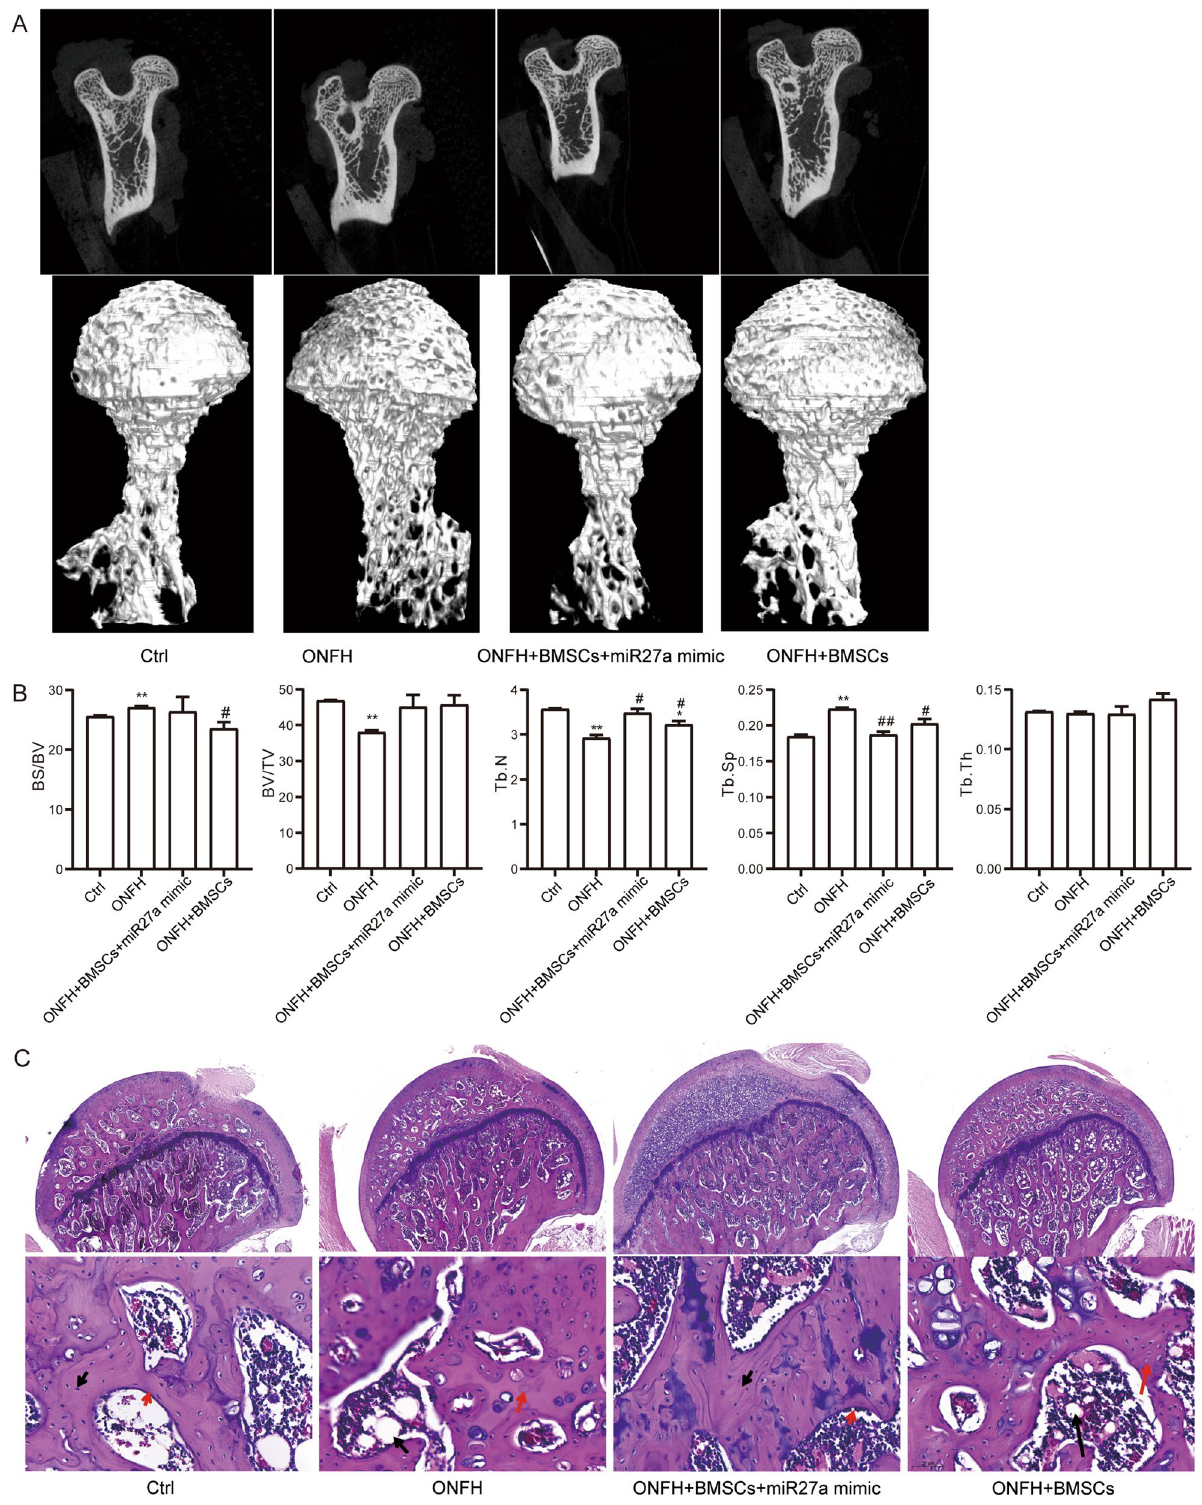
Figure 4. miR-27a protect bone tissue in steroid-induced ONFH rats. ( A ) Micro-CT scanning images of femoral head of rat models. ( B ) The BS/BV, BV/TV, Tb.N, Tb.Th, and Tb.Sp values of rat femoral heads in different groups. ** P < 0.01 vs controls, ## P < 0.01 vs steroid-induced ONFH. ( C ) Hematoxylin–eosin staining of femoral head of rat models. Black arrows, dipocyte; red arrows, empty bone